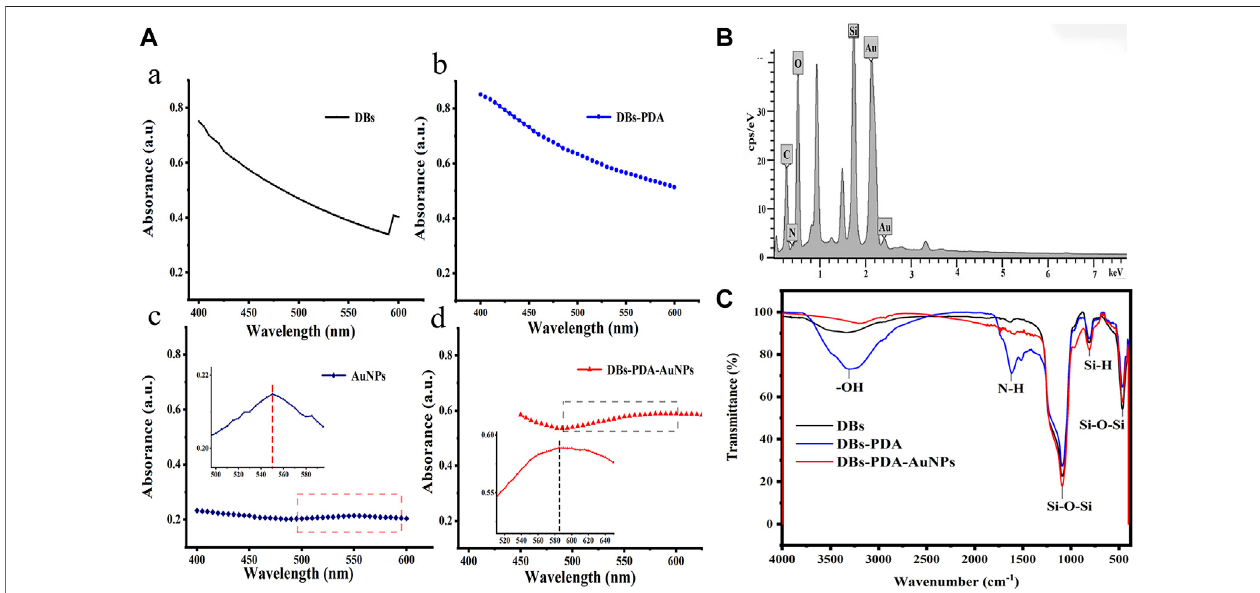
FIGURE2|(A) UV-Visabsorptionspectraof (a) DBs, (b) DBs-PDA, (c) AuNPs(Inset:theUV-VisabsorptionspectrumofAuNPsfrom495to600 nm),and (d) DBs- PDA-AuNPs (Inset: the UV-Vis absorption spectrum of DBs-PDA-AuNPs from 510 to 650 nm). (B) EDS spectrum of DBs-PDA-AuNPs. (C) FITR spectra of DBs, DBs- PDA, and DBs-PDA-AuNPs.